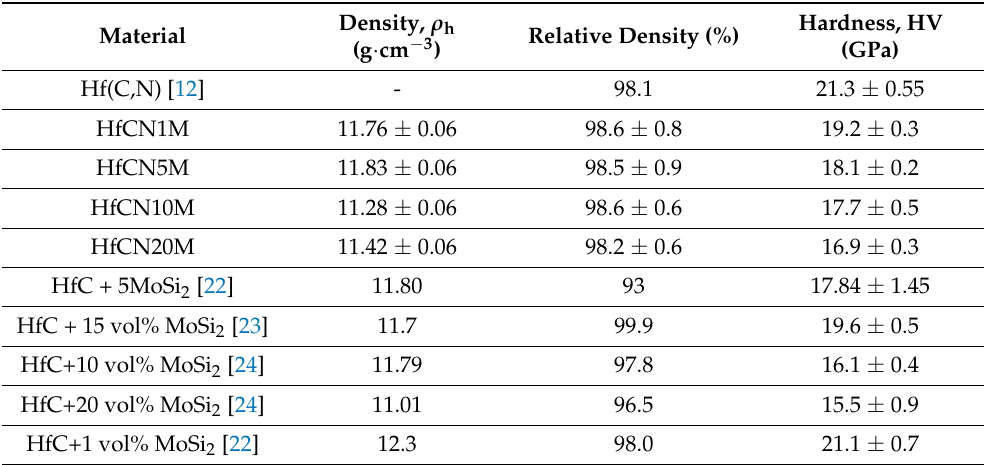
Table 2. Mechanical properties of composites with MoSi 2